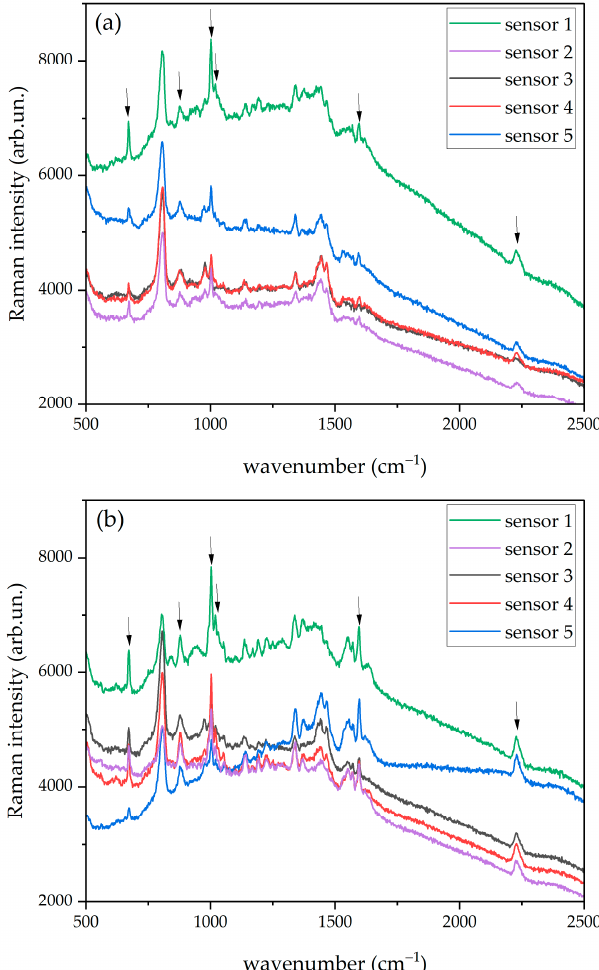
Figure 8. Representative set of SERS spectra (PER 5 × 10 − 5 M) recorded in dynamic mode on five different sensors produced either by ( a ) natural sedimentation or ( b ) centrifugation. 632.8 nm excitation laser, 5 mW incident power, 10 s exposure time (5 averages), 20× objective. The spectra are plotted with intensities in common scale. All the spectra are reported with no background subtraction and no normalization. The main PER peaks are highlighted by arrows.